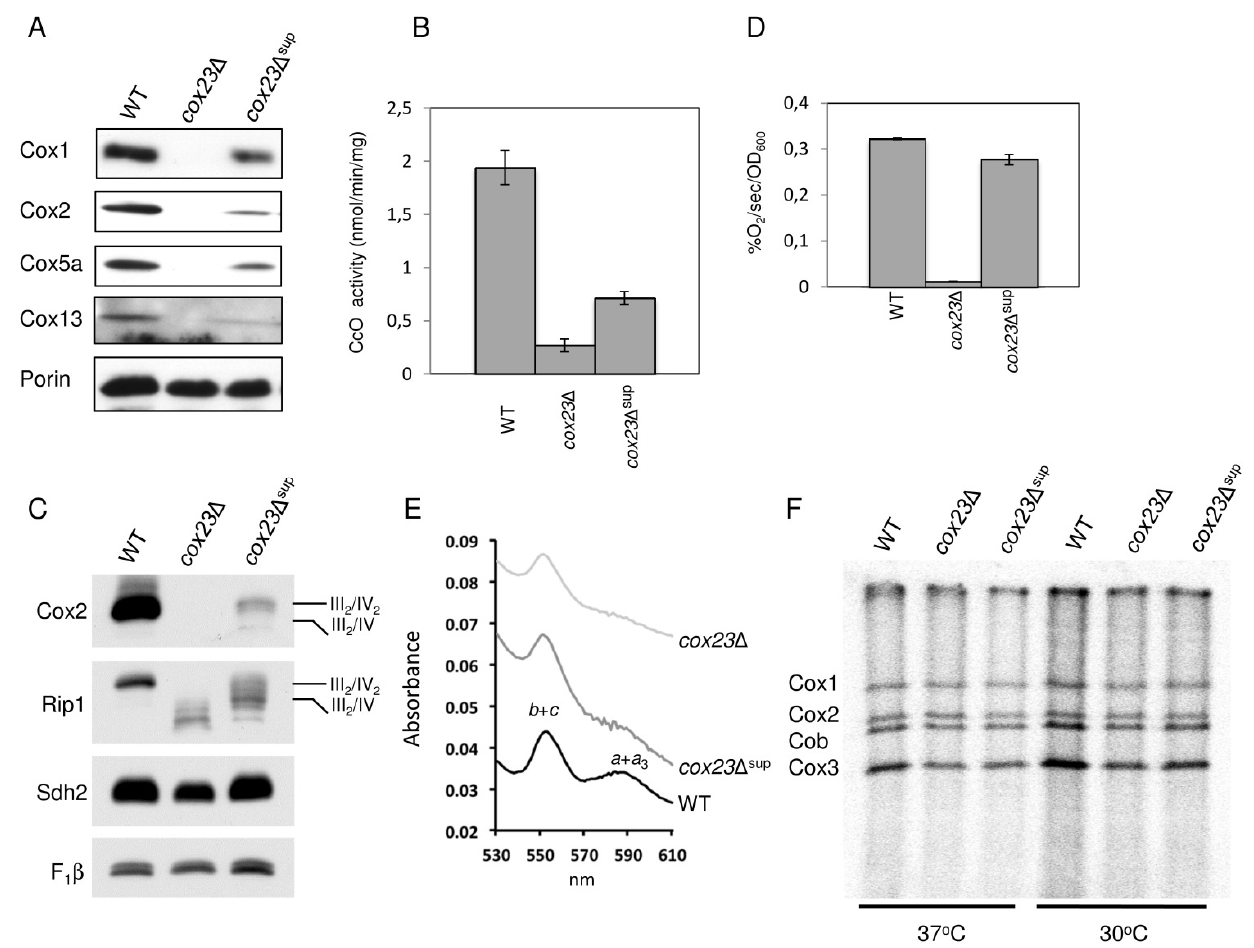
FIGURE 2: Functional characterization of cox23 Δ suppressor. (A) Steady-state concentration of representative Complex IV (CIV) subunits. Total mitochondrial protein (20 μg) were separated on 12% SDS-PAGE, transferred to nitrocellulose and probed with CIV subunit specific antibodies and porin as loading control. (B) Mitochondria from WT, cox23 Δ, and cox23 Δ suppressor cells grown in liquid YPGal were purified and assayed for CcO activity (nmol cytochrome c oxidized/min/mg protein). The data represents the average of four independent experiments (error bars indicate standard deviation). (C) Total mitochondrial protein (30 μg) were solubilized in 1% digitonin, the mitochondrial protein complexes sep- arated on a blue-native gel, then transferred to PVDF. The complexes were visualized using antibodies specific to subunits of the respiratory complexes. (D) WT, cox23 Δ, and cox23 Δ suppressor cells were grown in liquid YP-Galactose (YPGal) at 30°C overnight and carbon-swapped to YPGL for 10 hours before oxygen consumption was measured. The data represents the average of three independent experiments (error bars indicate standard deviation). 1000 cells were plated in YPD-agar to confirm viability (data not shown). (E) Pyridine hemochromes analysis of mitochondrial hemes. Optical absorbance spectra were recorded of reduced minus oxidized cytochromes in the shown strains. (F) Mitochondri- al proteins of wild-type (WT), cox23 Δ, and cox23 Δ suppressor cells were pulse-labeled with [ 35 S]-methionine for 7.5 min at 30°C and 37°C. Total protein were extracted and separated on 15% polyacrylamide gel, then dried and exposed to x-ray